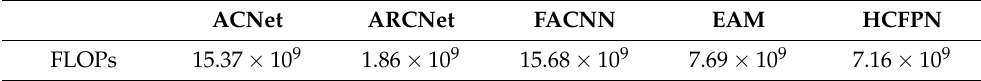
Table 6. The number of FLOPs for all models when an image of size 3 × 224 × 224 is input.